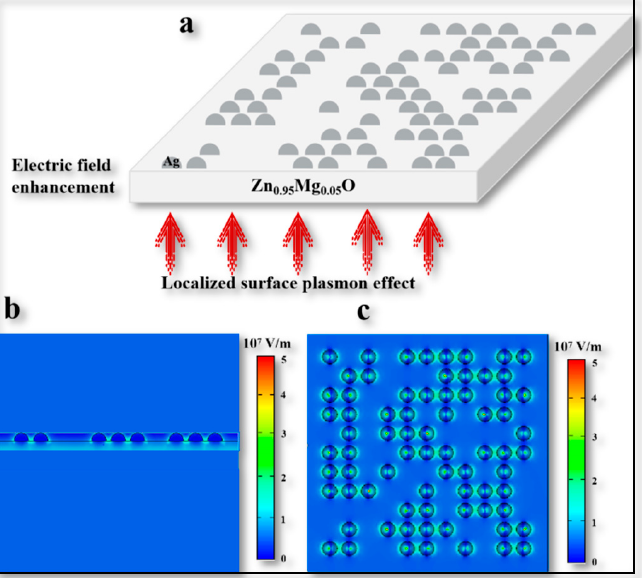
Figure 5. CST Simulation diagram. ( a ) Schematic diagram of established simulation model. ( b ) Section diagram of simulation results. ( c ) Vertical view of simulation results.